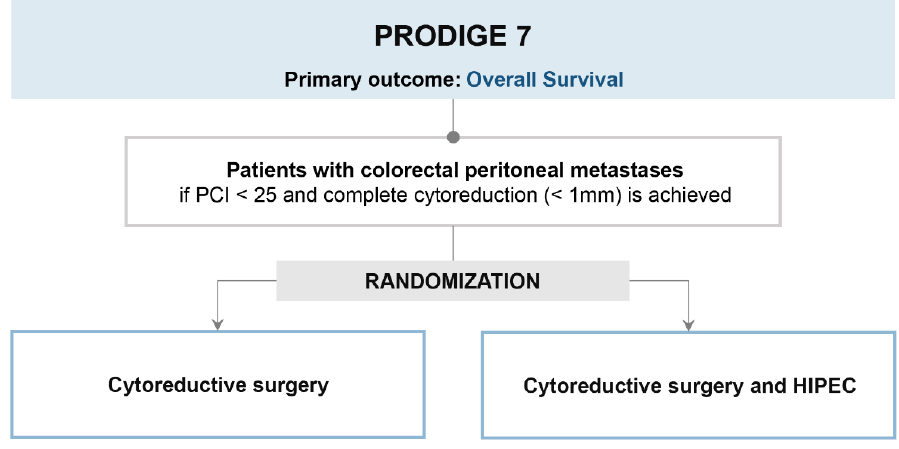
Figure 1. PRODIGE 7 trial design.